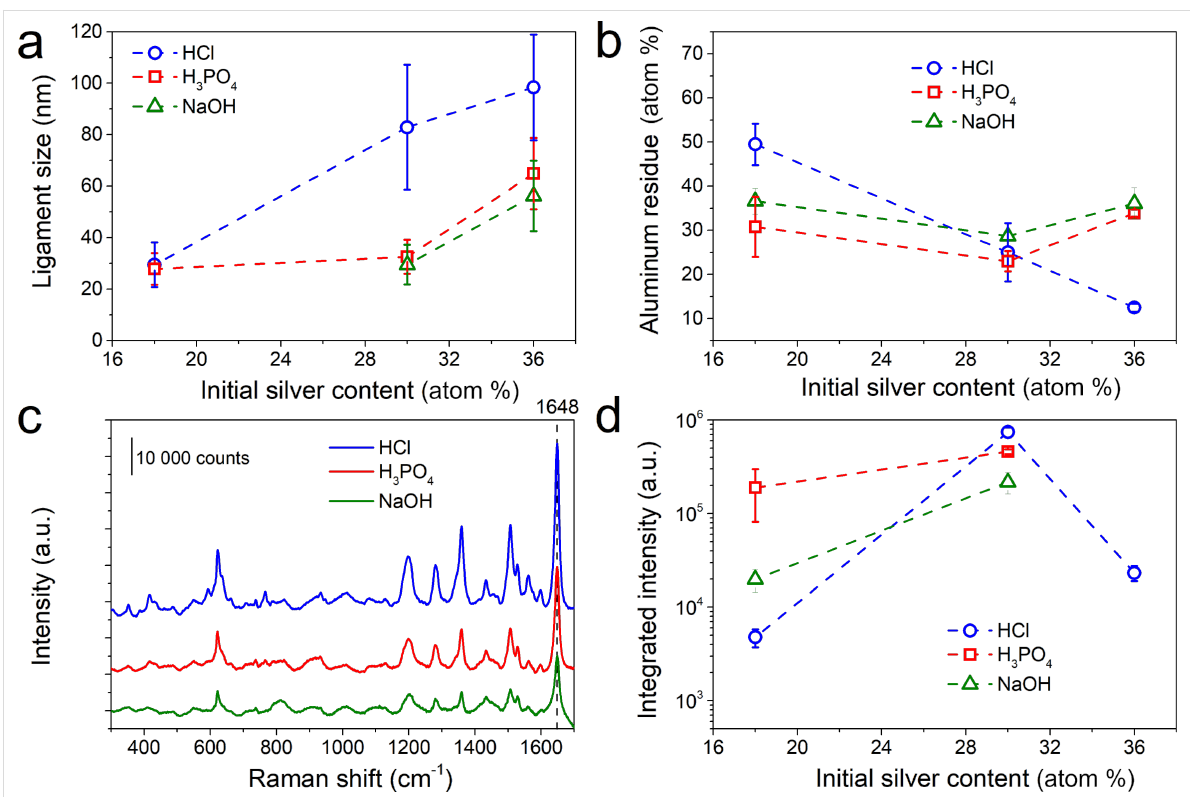
Figure 7: Evolution of the (a) ligament size and (b) aluminum residue for samples with different initial silver content at the initial state and dealloyed for 60 min in HCl (blue), H 3 PO 4 (red), and NaOH (green). (c) Raman spectra recorded after 24 h of incubation in a 10 − 7 mol·L − 1 RhB solution for Ag–Al samples with an initial amount of silver of 30 atom % and dealloyed for 60 min in (blue) HCl, (red) H 3 PO 4 , and (green) NaOH. (d) Comparison of the integrated intensity of the peak at 1648 cm − 1 for samples with different initial silver content and dealloyed for 60 min in different solutions incu- bated for 24 h in 10 − 7 mol·L − 1 of RhB.